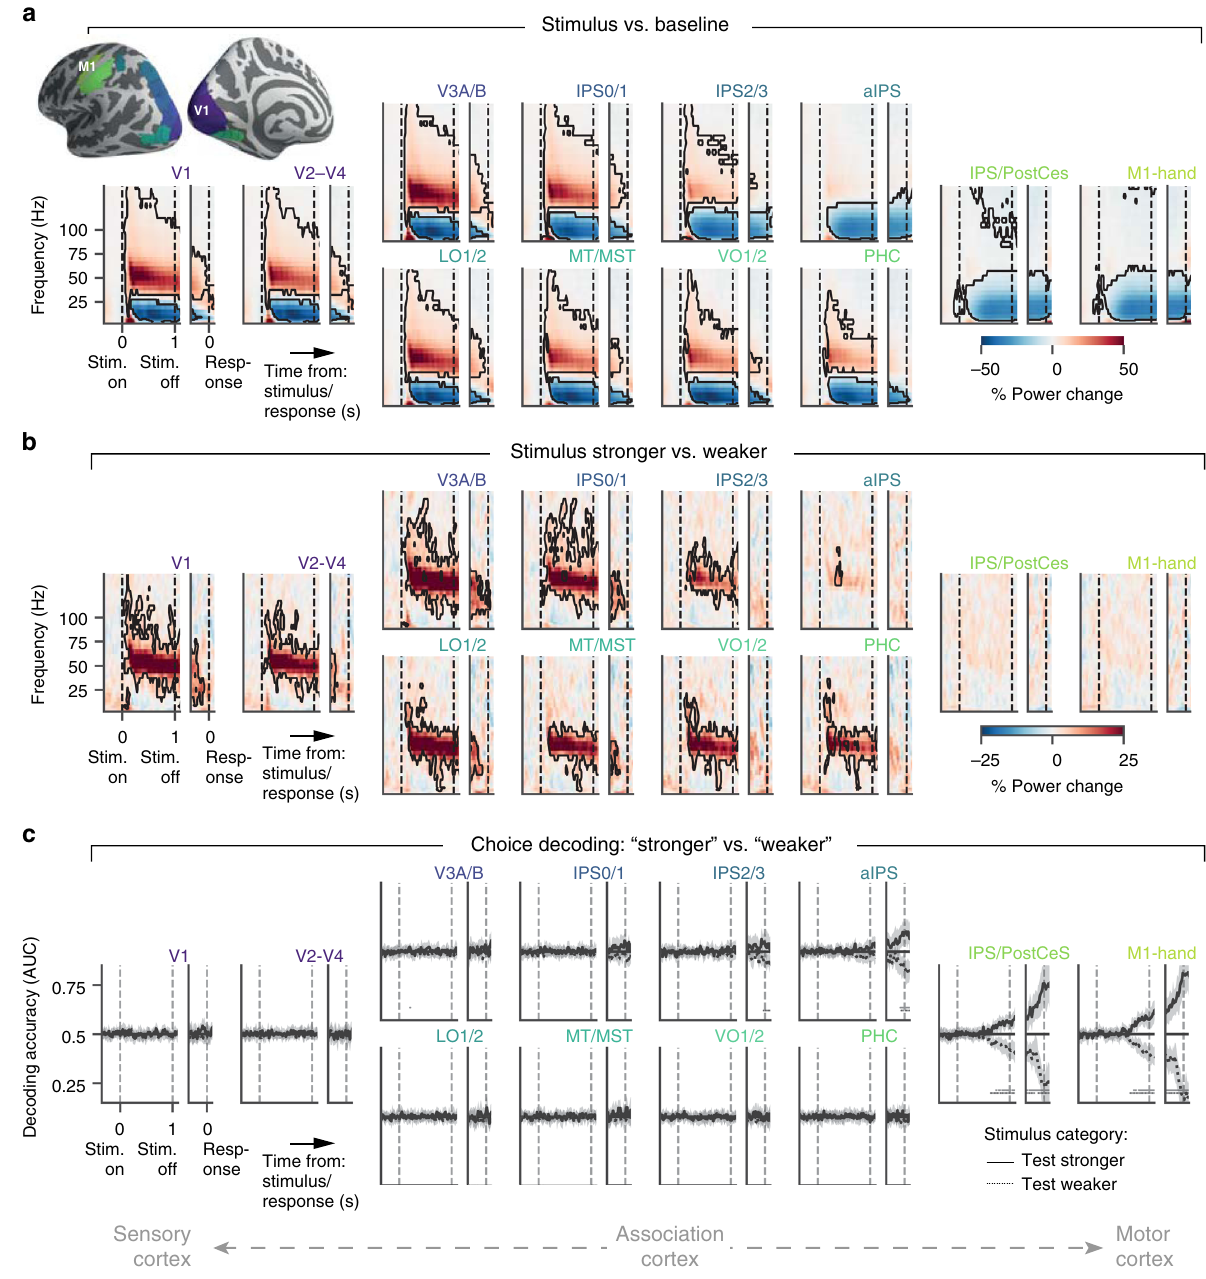
Fig. 2 Task-related neural dynamics across the visuo-motor cortical pathway. a Time-frequency representations (TFRs) of group average power change relative to pre-stimulus baseline ( − 250 to 0 ms relative to test stimulus), for several cortical regions along the cortical sensory-motor axis. Top left inset, colors of areas depicted on cortical surface. For each area, data are shown time-locked to test stimulus-onset in the left partition of each TFR and time- locked to the choice, in the right partition (partitions separated by white spacing). Data are represented as mean ( n = 15, color code). Black contour, p < 0.05 (cluster-based, two-sided permutation test against 0). b As a , but for power differences between stronger and weaker test stimulus categories. c Time courses of regionally speci fi c decoding of choices (see “ Methods ” ), separately for the two test stimulus categories. Data are represented as mean ( n = 15 subjects, lines) and 95% highest density interval (shaded areas) of posterior distributions over group average decoding accuracies. Horizontal bars, p < 0.05 (cluster-based permutation test: AUC different from 0.5, n = 15 subjects). Source data are provided as a Source Data fi (contra- vs. ipsilateral to effector choice) of M1-hand in our data Choice-predictive activity in IPS/PostCeS was partially inde- (Supplementary Fig. 6a). Correspondingly, decoders trained on pendent of M1-hand: When eliminating signal leakage by the spectral power pro fi les from both hemispheres revealed removing M1-hand power from IPS/PostCeS power for each choice-predictive build-up activity in M1-hand, as well as IPS/ frequency (via linear regression), the residual IPS/PostCeS activity PostCeS (Fig. 2c). Choice decoding in these regions ramped up still yielded signi fi cant choice decoding (AUC = 0.53, time = 1.1 s; more quickly before choices associated with high than with low t (14) = 2.01, p = 0.032). Movement-speci fi c activity in IPS/ con fi dence (Supplementary Fig. 6b). PostCeS has previously been observed with fMRI during